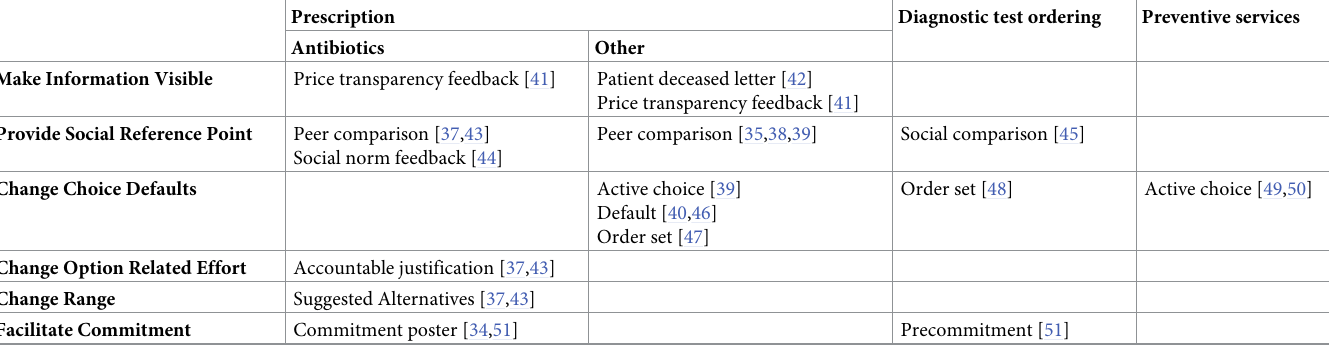
Table 4. Overview of interventions examined in included studies by intervention category and primary outcome